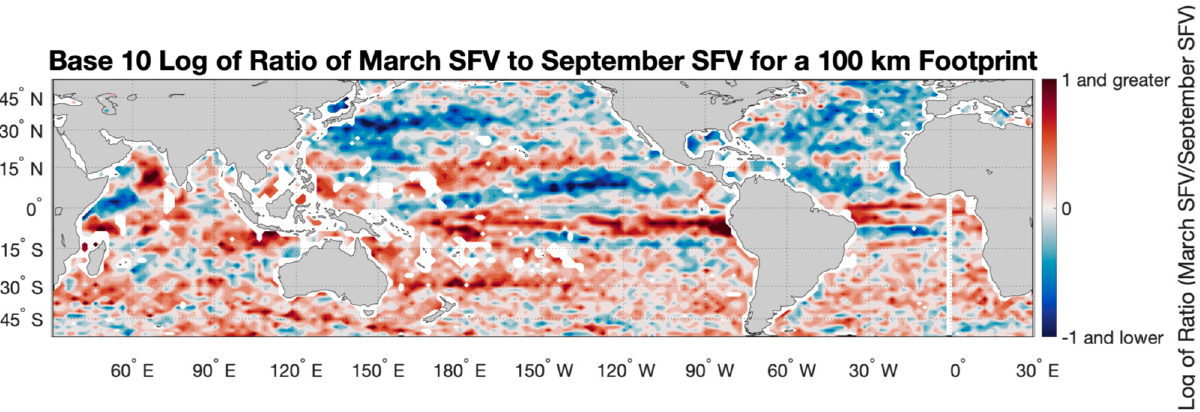
( b ) Same but for 40 km footprint.